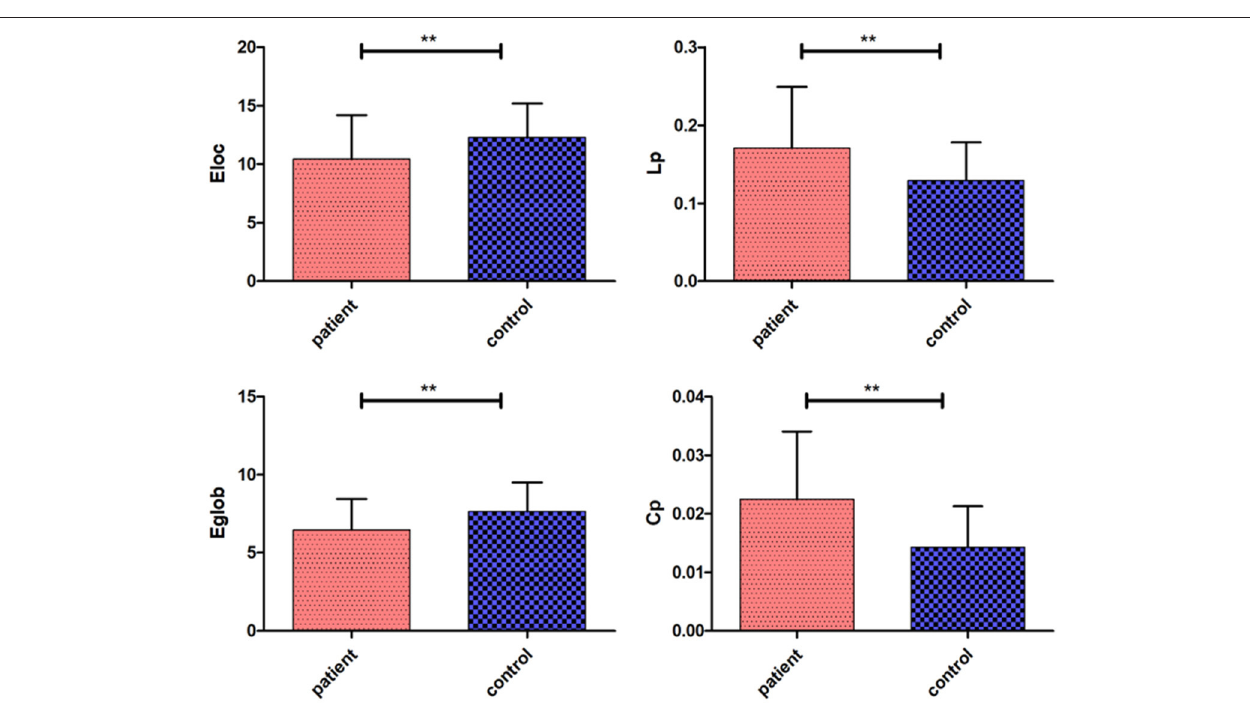
FIGURE 1 | Significantly different network parameters at a threshold T = 3 between cerebellar infarction and healthy controls. Bars and error bars indicate the mean and standard deviation. The asterisk marks indicate a significant difference between the two groups ( p < 0.05).